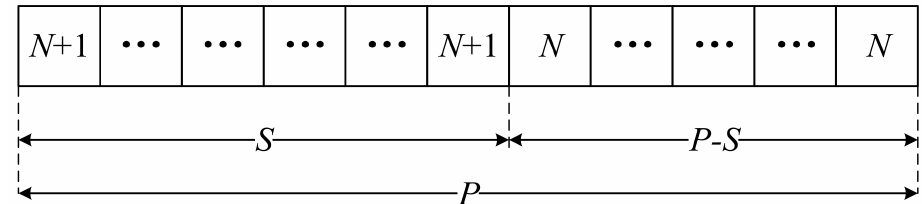
Figure 2. Working principle illustration for the frequency division ratio of the improved pro- grammable frequency divider.